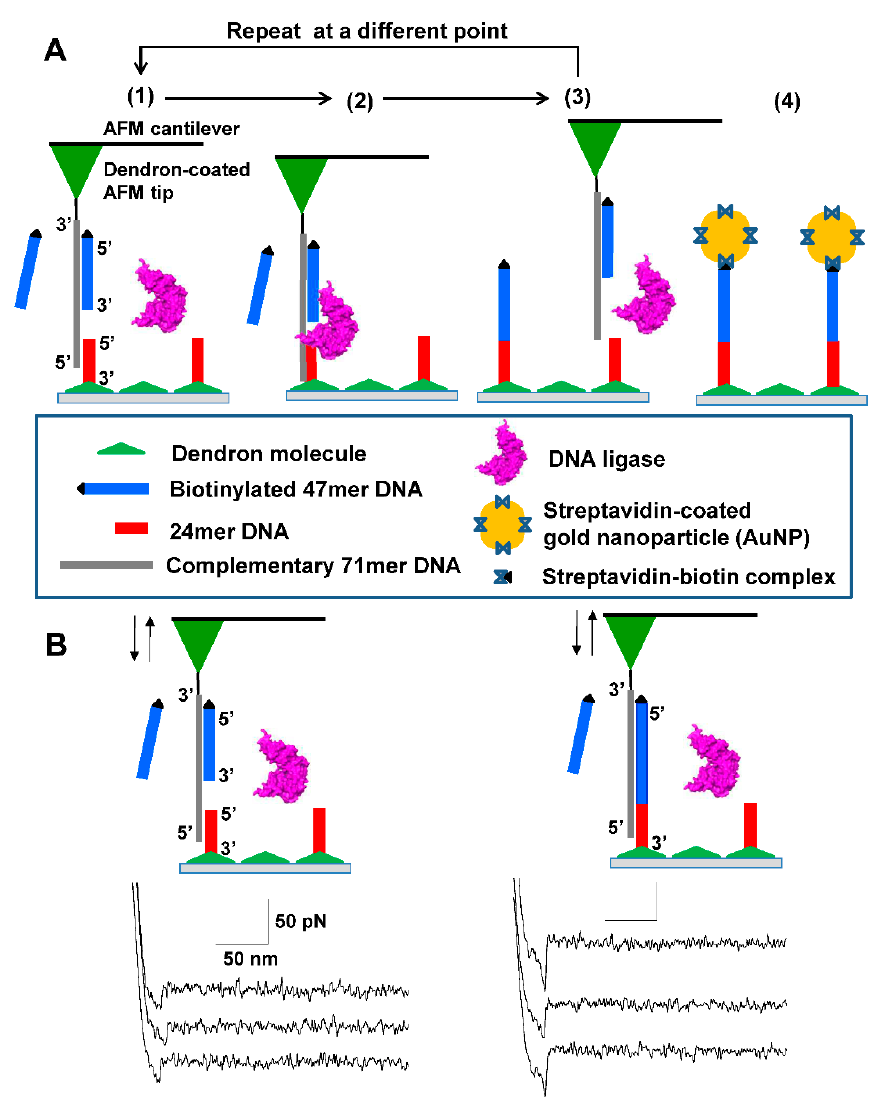
Figure 1. Successive DNA ligation for covalently positioning single DNA molecules. ( A ) Scheme of four-step process: ( Step 1 ) A free 47mer DNA (in blue) modified with a biotin residue (represented by the black triangle) linked at its 5 (cid:48) end is hybridized to the complementary 71mer (c71mer) DNA (in gray) immobilized on the tip of the AFM cantilever in the DNA ligation solution; ( Step 2 ) The AFM tip is made to approach a 24mer DNA immobilized on the dendron-coated surface to introduce a single nick between the 5 (cid:48) end (that is, a phosphate group) of the 24mer DNA and the 3 (cid:48) end (that is, a hydroxyl group) of the 47mer DNA. The nick can be sealed by the DNA ligase, which forms a new phosphodiester of the c71mer DNA with a new free 47mer DNA. The direct immobilization